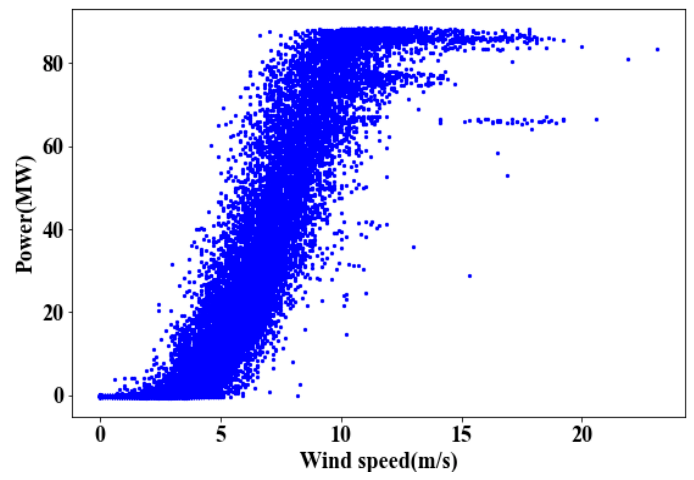
Figure 2. The scatter diagram describes the relationship between wind speed and wind power.